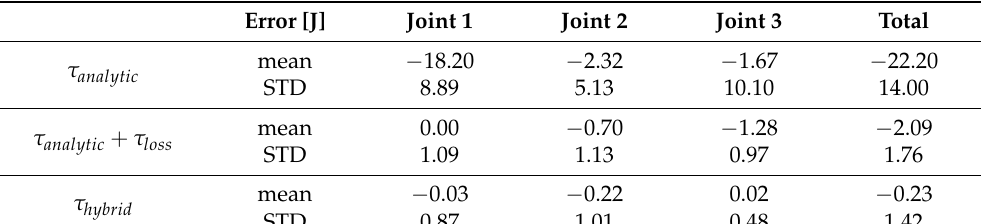
Table 1. The energy consumption discrepancy between the empirical manipulator and the models with different compensation terms.